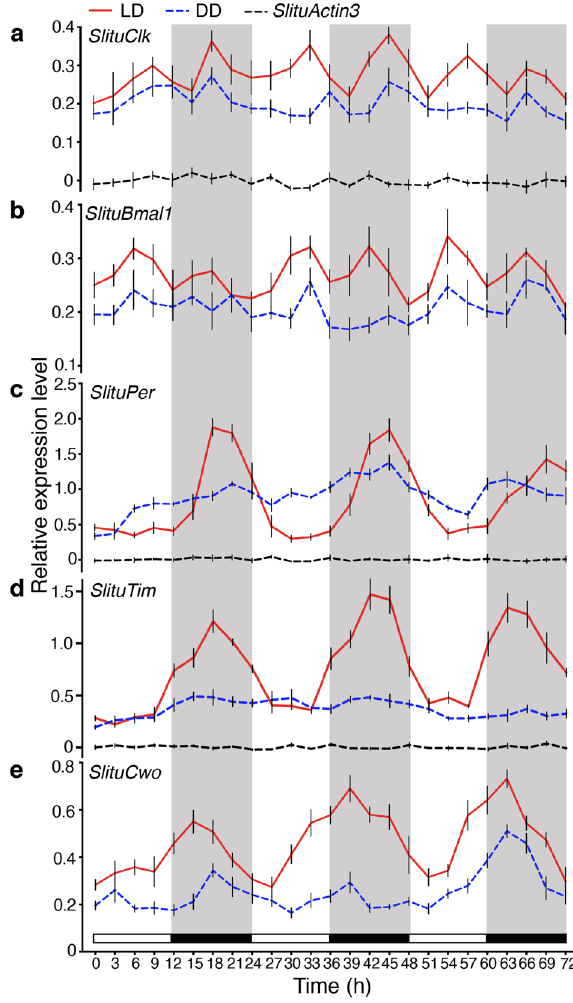
Fig. 3 RT-qPCR analyses of core circadian gene transcription in larval brain. Amounts of transcripts of SlituClk ( a ), SlituBmal1 ( b ), SlituPer ( c ), SlituTim ( d ), and SlituCwo ( e ) during 6LD1 to 6LD3 under LD 12:12 (red solid line) and DD (blue dashed line) after entrainment by LD 12:12. Brains were collected from 3 groups with 10 individuals each at 3 h intervals for 72 h under the two conditions. The expression pro fi le of the reference gene SlituActin3 (black dotted line) is shown after homogenization with log10. Light and black shade represent the photophase and scotophase. The results are given as mean ± SEM of three independently repeated